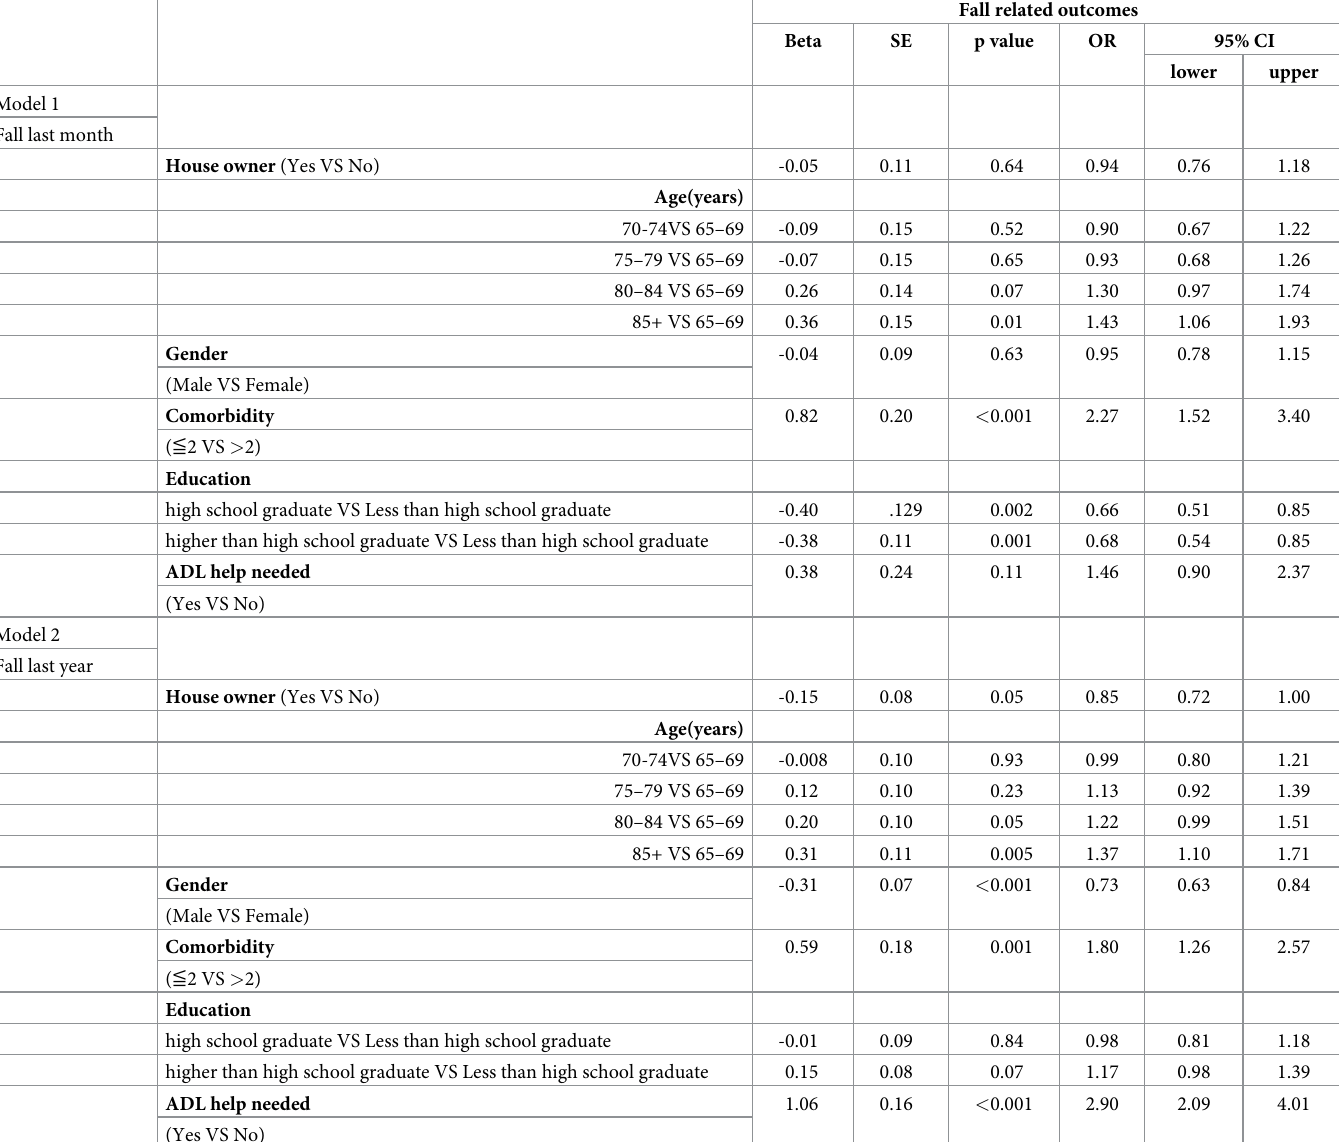
Table 3. Multiple logistic regression model of independent effort of house owner to fall related